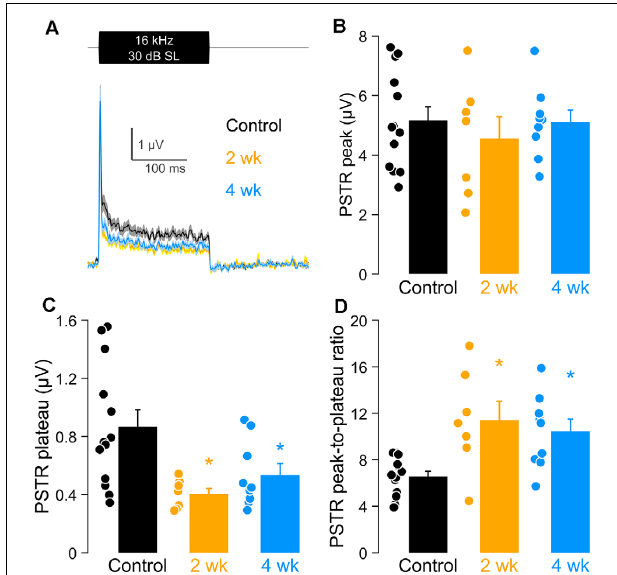
FIGURE 7 | PSTR peak, plateau, and peak-to-plateau ratio after noise exposure at 16 kHz. (A) PSTRs in response to a burst of third-octave band noise presented at 30 dB above PSTR threshold. (B–D) PSTR peak (B) , plateau (C) , and peak-to plateau ratio (D) in unexposed and exposed animals, with group sizes as given in the Figure 1 caption. Closed circles indicate individual data. (B–D) Data are shown as means ± SEM and compared using a one-way ANOVA and a post hoc test for multiple comparisons of groups; * p <